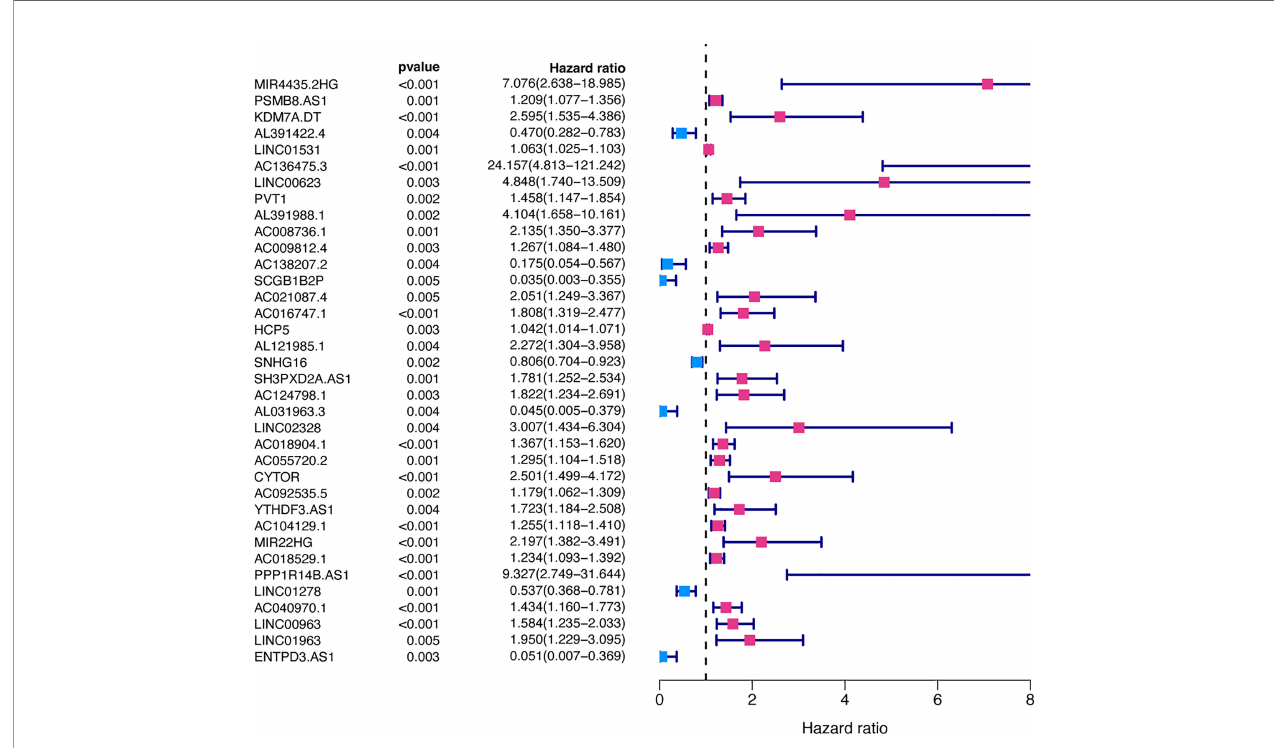
FIGURE 2 | Prognosis-related FRLs from the training set screened using univariate Cox regression